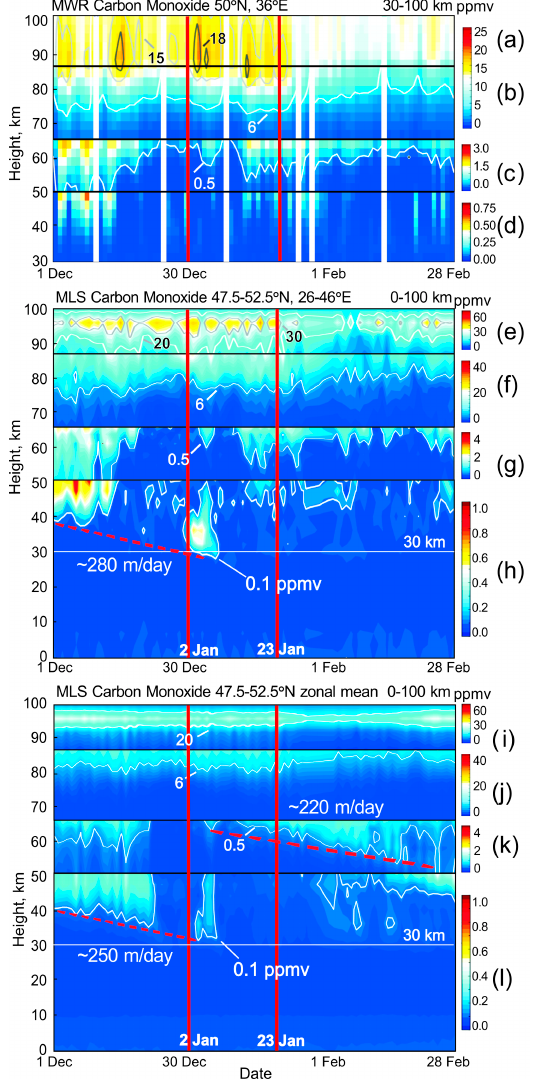
Figure 7. Vertical profile variations of mesospheric carbon monoxide (CO) by MWR (Kharkiv) and MLS [42] data in the SSW2 event: ( a – d ) Local mesospheric and stratospheric CO profiles from MWR measurements over Kharkiv in the altitude range 30–100 km; ( e – h ) regional CO profiles from MLS measurements averaged over latitudes 47.5–52.5 ◦ N and longitudes 26–46 ◦ E centered at the Kharkiv MWR site (50 ◦ N, 36 ◦ E); and ( i – l ) CO profiles from the MLS zonal means in latitudinal band 47.5–52.5 ◦ N. Selected CO levels are highlighted by white, grey, and black contours (see text for details). Data for December 2018–February 2019 are presented and the time interval of significant variations in atmosphere parameters due to the SSW2 event from 2–23 January 2019 is bounded by red vertical lines.